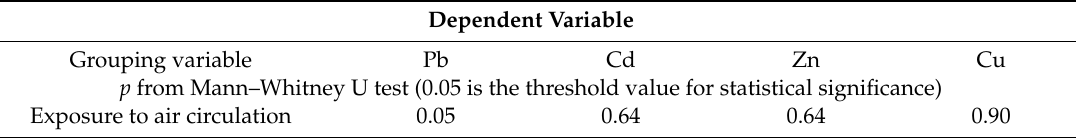
Table 6. Stratification of heavy metal concentrations in polyfloral honey.